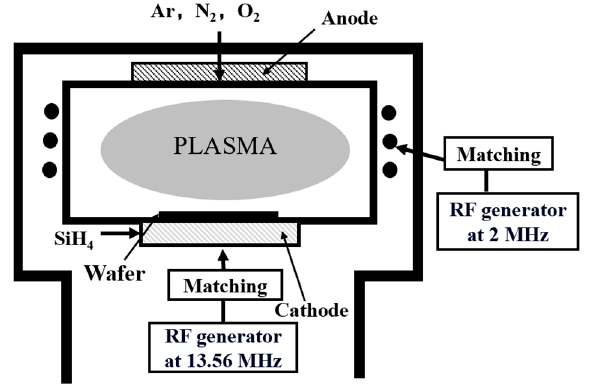
Figure 2. Schematic of the ICP-CVD apparatus.